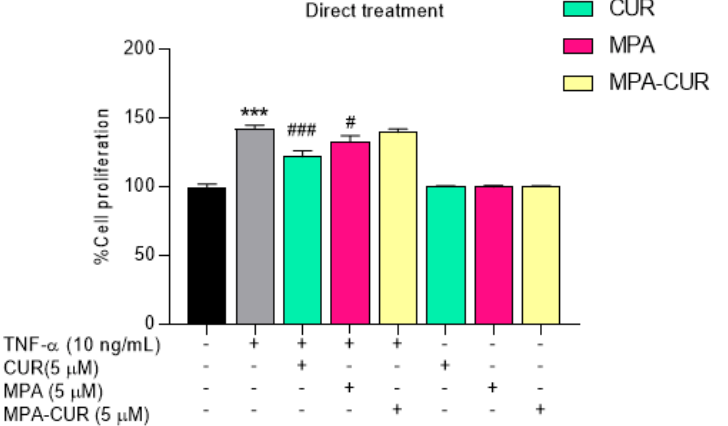
Figure 3. Cell proliferation of TNF- α -induced HaCaT cells incubated with MPA, CUR, and MPA- CUR for 24 h in the direct treatment. Data presented are mean ± SD values of three replicates *** p < 0.001 indicates significance from the untreated control cells, # p < 0.05 and ### p < 0.001 indicates significance from TNF- α control group.